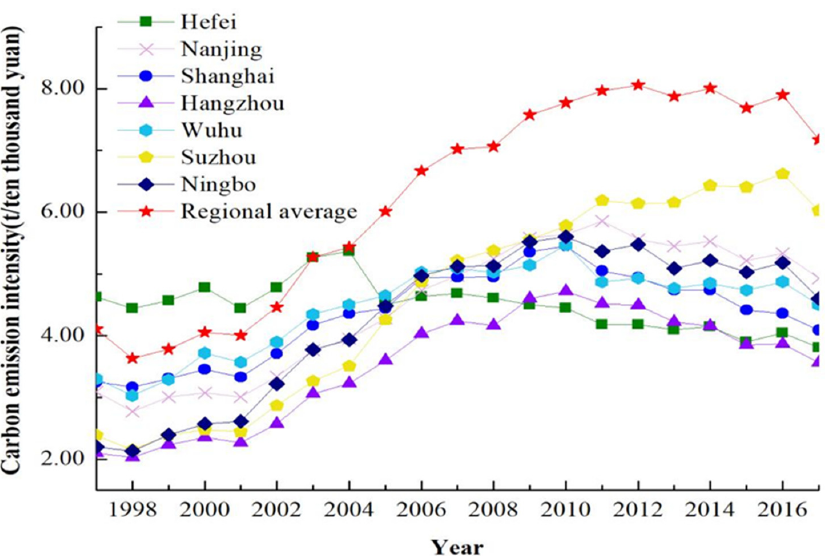
Figure 2. Temporal variation of carbon emission intensity of typical cities in the Yangtze Delta from 1997 to 2017.